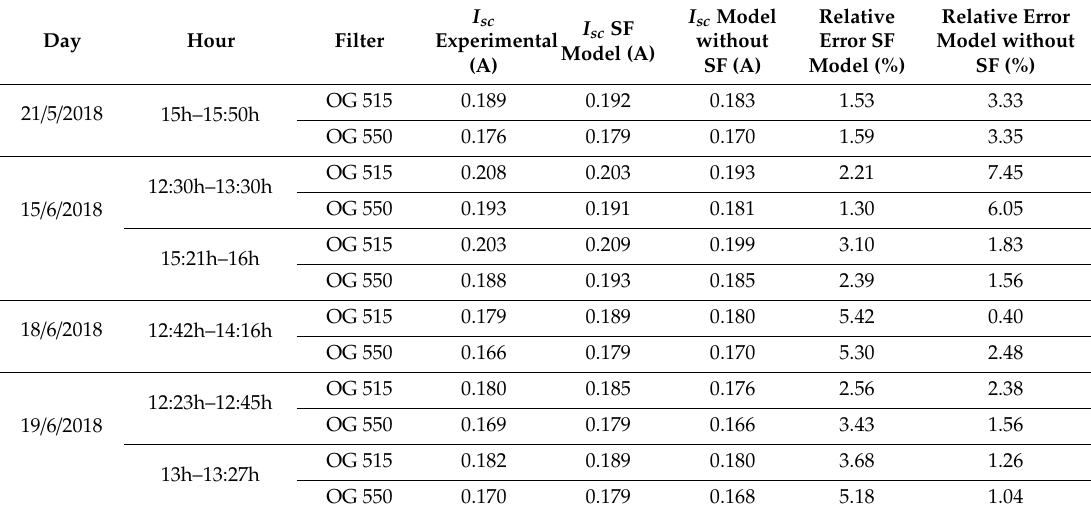
Table 9. Values of short-circuit current and their respective relative errors for HP filters.